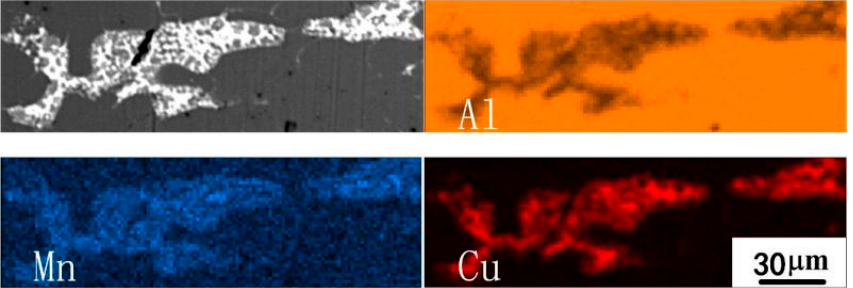
Figure 3. The EDS data of the primary phase in the central segregation region of ACMZ, as cast. Compared with Figure 4a–c, it can be found that with the increase in nanoparticle content, the segregation area in the as-cast structure of the alloy gradually decreases, and the large pieces of primary phases also disappear. The structures on both sides of the central segregation area tend to be consistent. It demonstrates that by adding nanoparticles, the composition uniformity in the alloy is improved. Comparing with Figure 4e–g, it can be found that ACMZ and ACMZ-0.1 nanoparticles will result in large residual second phases after isothermal holding + solid solution treatment (IS), and these undissolved residual areas roughly maintain the contour of the original large Al 2 Cu, as shown in the small figure of Figure 4e. The T phase is an insoluble phase. After solution treatment, the shape of the T phase aggregation area is approximately the same as that of the previous sheet θ . According to Figure 5, this area is the mixture of Al 2 Cu and T phase. It shows that the T phase precipitates on Al 2 Cu, and it hinders the dissolution process of Al 2 Cu during solution. In ACMZ-0.3 nanoparticles, because the as-cast microstructure is uniform and no large segregation area exists, only a tiny amount of residual T phase appears at the edge of the grain boundary after isothermal holding and solution treatment. After isothermal holding, dispersed T phase with a diameter of about 200–400 nm precipitates in the alloy, and the content of T phase in α (Al) will increase slightly with the increase of nanoparticle content compared with Figure